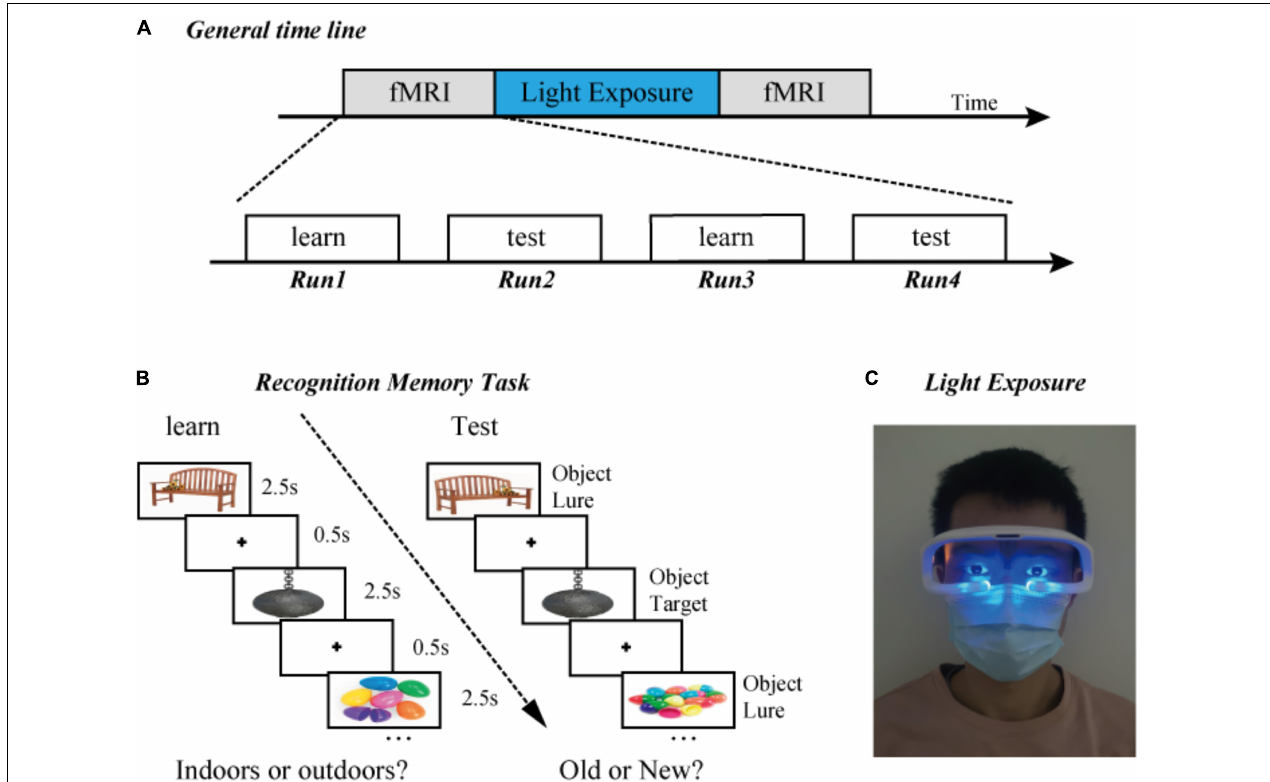
FIGURE 1 | Experimental design. (A) General timeline. (B) Examples of the presentation format in the “indoors/outdoors” and “old/new” judgment task. Participants learned a series of objects, which was followed by a recognition test. (C) Diagram of light exposure. All participants received 0 or 40-Hz blue light stimulation in a dark room for 1